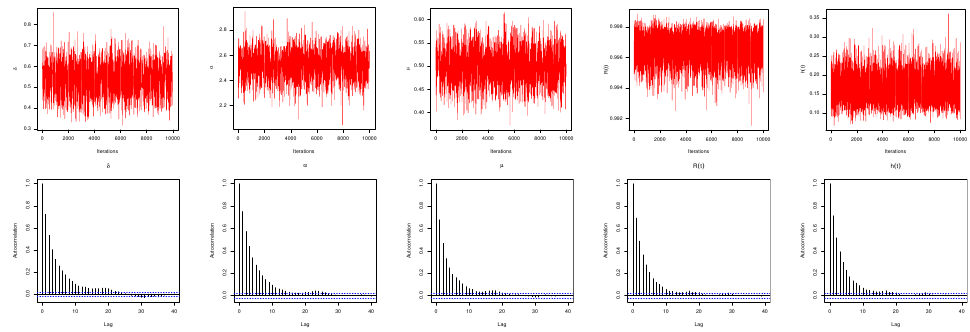
Figure 3. Trace ( top ) and autocorrelation ( bottom ) plots for MCMC draws of δ , α , µ , R ( t ) and h ( t ) . 40[50%]−140[50%]−240[50%]−340[90%]−140[90%]−240[90%]−380[50%]−180[50%]−280[50%]−380[90%]−180[90%]−280[90%]−3